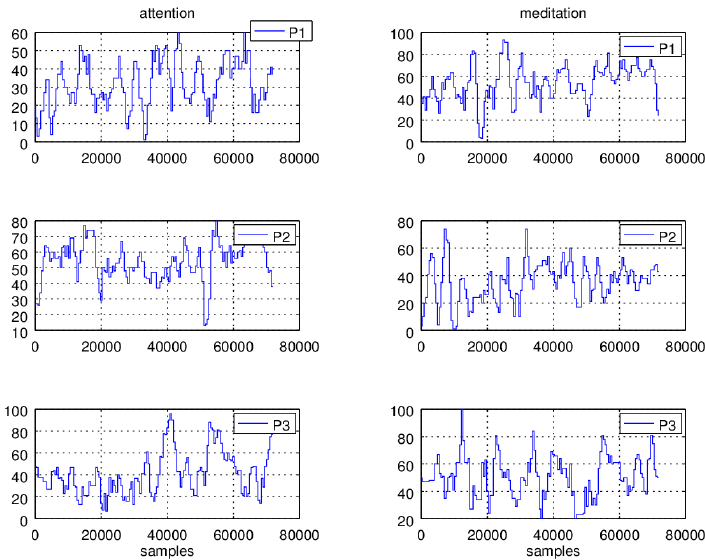
Figure 8. Attention and meditation readings of three individuals, P1 , P2 , and P3 car drivers.